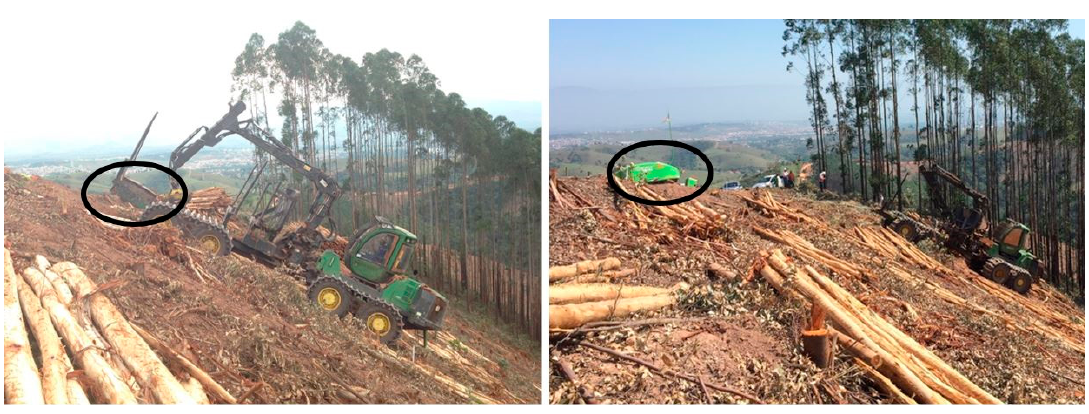
Figure 2. HAAS machine-mounted traction winch, circled left, and T-WINCH self-contained traction winch, circled right, used in conjunction with a John Deere 1910E forwarder.